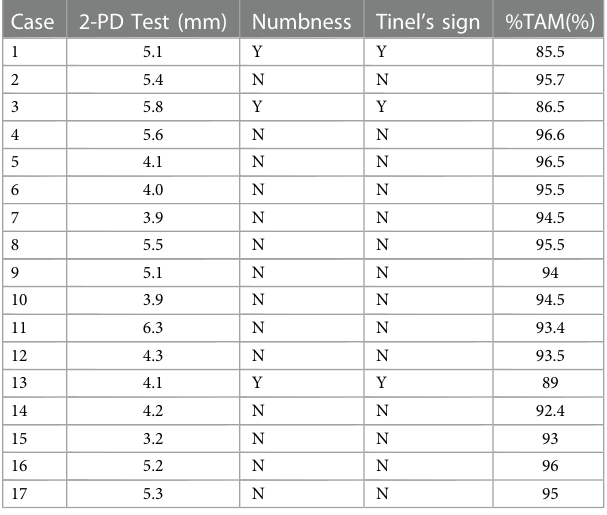
TABLE 2 Postoperative assessment of sensation and active range of motion (ROM).